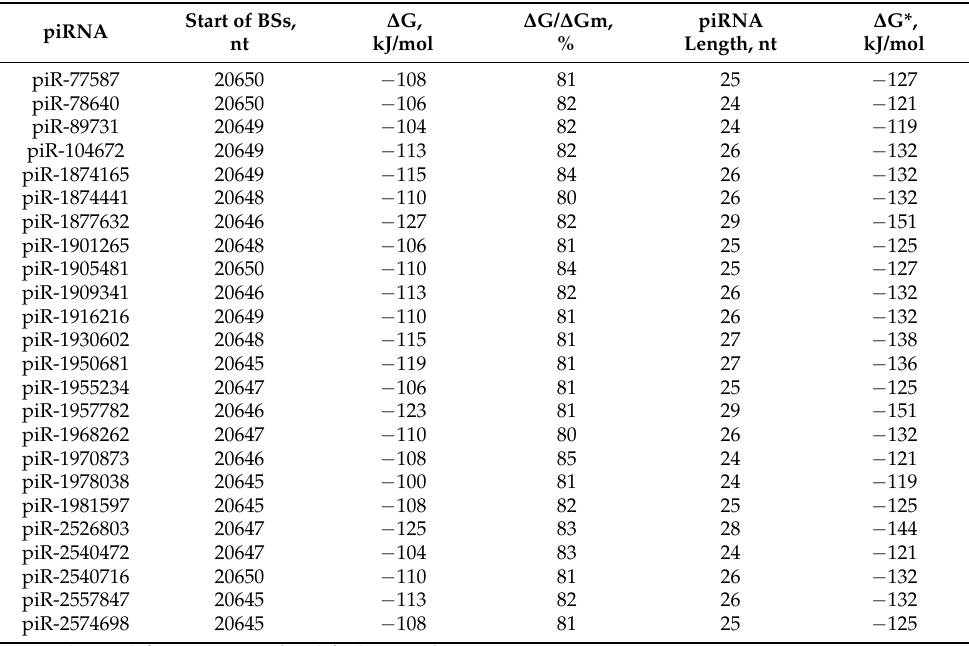
Note. ∆ G* is ∆ G for spiRNA with ∆ G/ ∆ Gm equal to